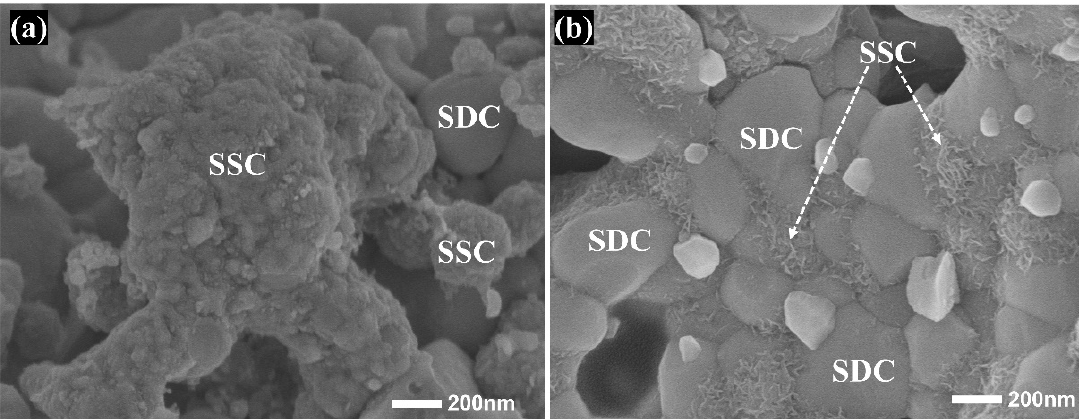
Figure 4. ( a ) SEM micrograph of SSC-SDC. ( b ) SEM micrograph of 5SSC@5SDC.